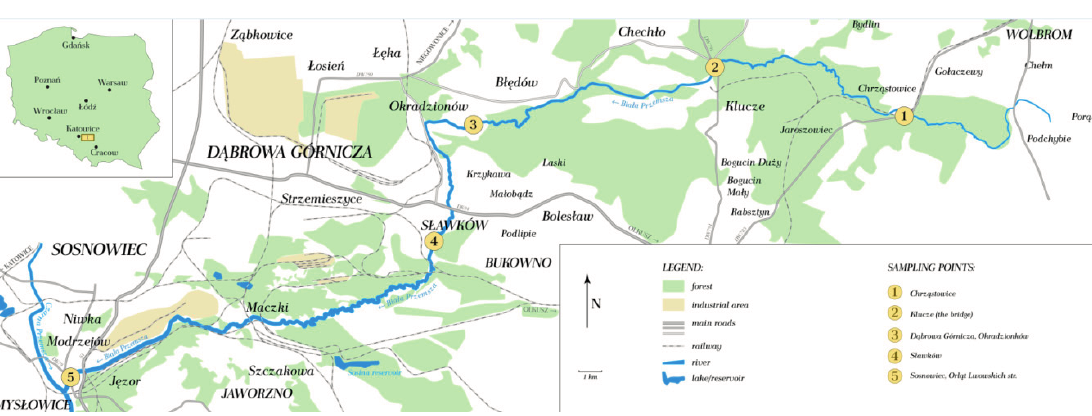
Figure 1. Location of the sampling points along the Bia ł a Przemsza